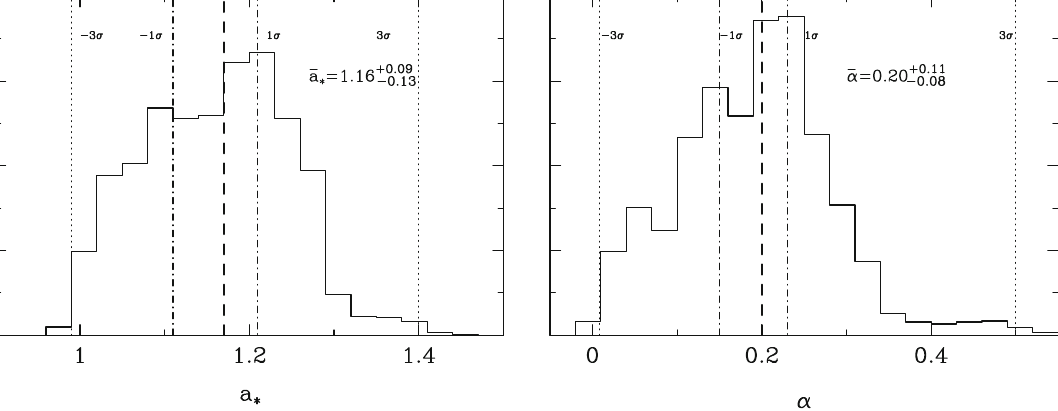
fitting parameter, while the thin-dotted-dashed and thin-dotted vertical lines mark, respectively, the 1- σ and 3- σ limits